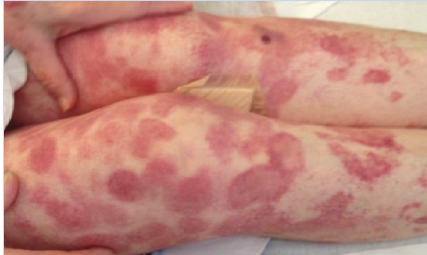
Figure 3: Multiple scattered irregular nodules on the patient’s legs. Bandage over excoriated